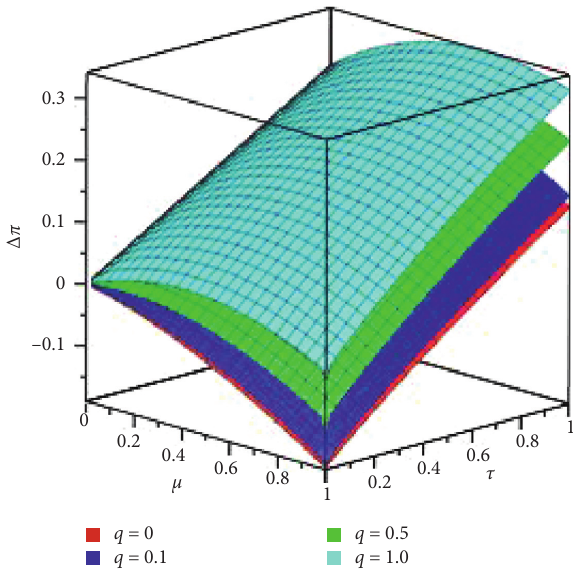
Figure 8: The changes of ( Δ π � π D ∗